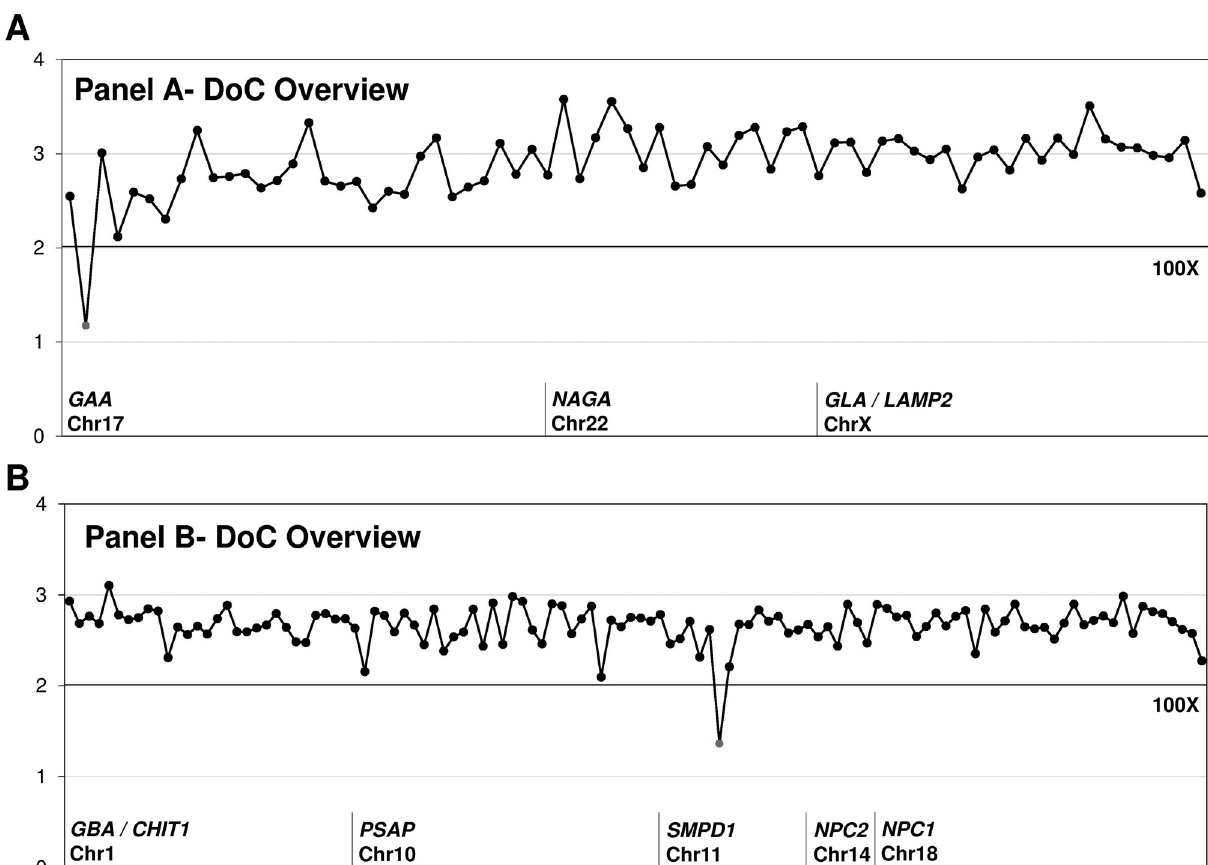
Figure 2 - Depth of Coverage (DoC) of panels presented in this study. Overview of all 191 custom amplicons designed for Panel A (73 amplicons) (upper panel A) and Panel B (118 amplicons) (lower panel B) for TNGS. The line indicates a DoC of 100X. Relative DoC is on the y-axis and amplicons are on the x-axis.